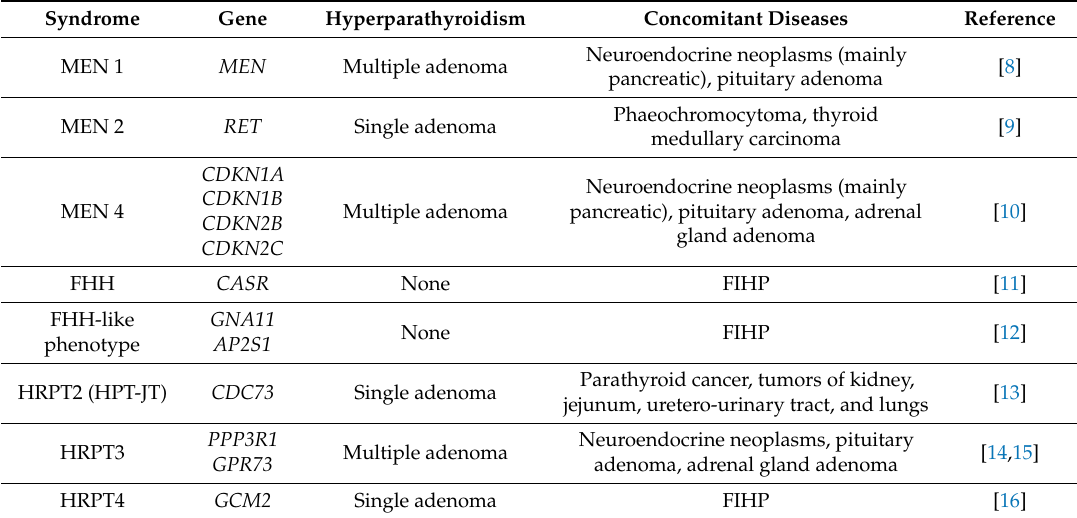
Table 1. Hereditary primary